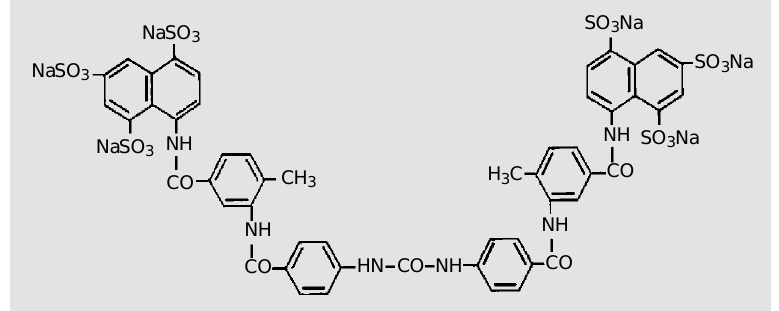
Figure 1. Structure of suramin, a polysulfonated naphthylurea (molecular weight